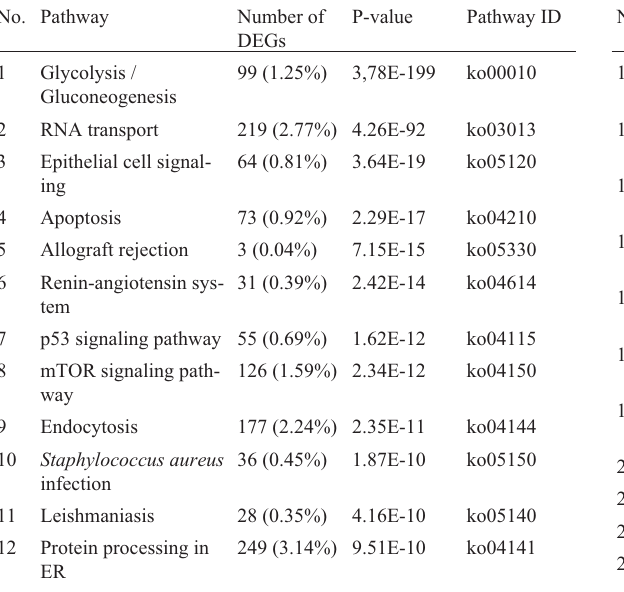
Table 4 - Top 80 differentially expressed pathways between GW and